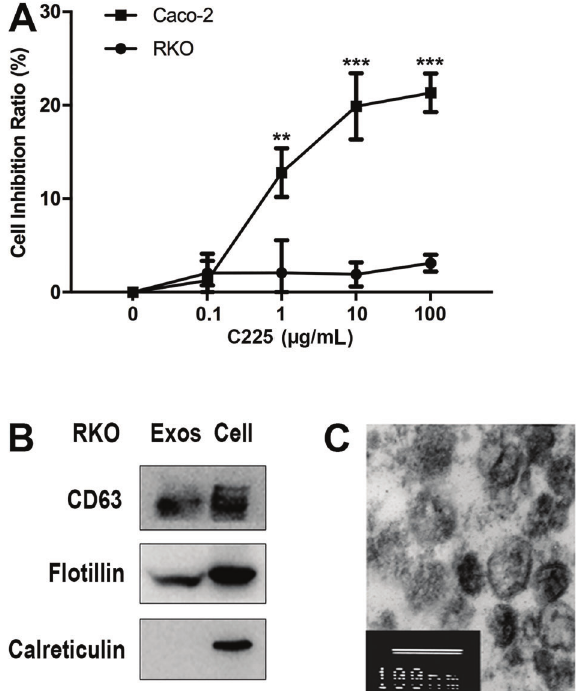
Figure 1. Identi fi cation of cetuximab-resistant RKO cell-derived exosomes. A , RKO and Caco-2 cells treated with increasing cetuximab concentrations (0, 0.1, 1, 10, and 100 m g/mL) for 48 h were assessed by the MTT assay to detect inhibition rates. Data are reported as means ± SD. **P o 0.01, ***P o 0.001, compared to control (one-way ANOVA, with Dunnett ’ s post hoc test). B , Western blot for detecting CD63, fl otillin and calreticulin pro- tein levels in exosomes from RKO cells and cell lysates with equivalent protein amounts. C , Transmission electron microscopy showing 30 – 100 nm size, saucer-shaped exosomes, enclosed by a lipid